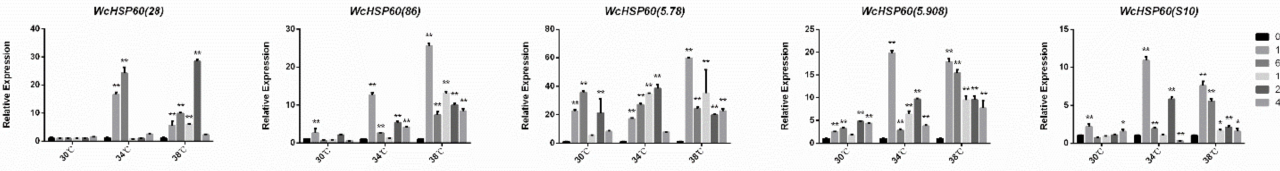
Figure 7. Analysis of expression patterns of WcHSP60 gene under different temperature treatments. The different strains ‘28’, ‘86’, ‘5.78’, ‘5.908’, and ‘S10’ of W. cocos are shown. All data are means ±